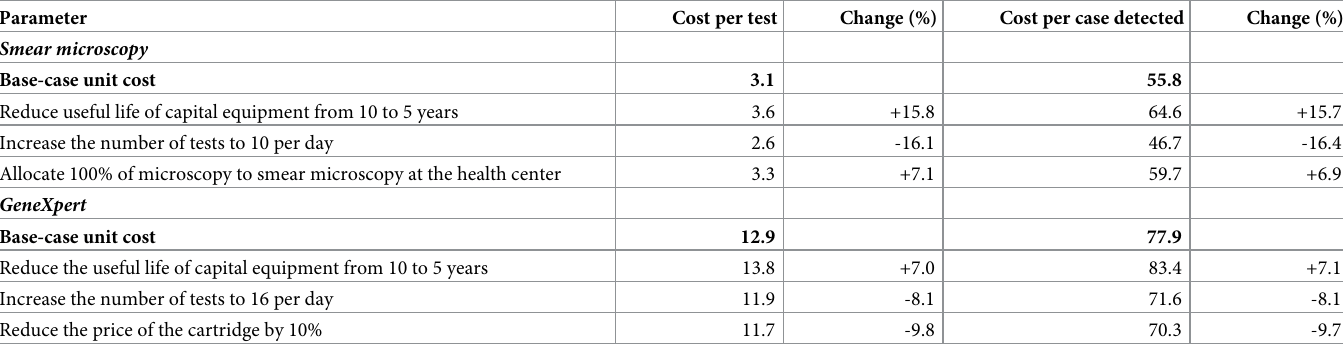
Table 5. Scenario analysis of cost assumptions for smear microscopy and Gene Xpert diagnostic methods